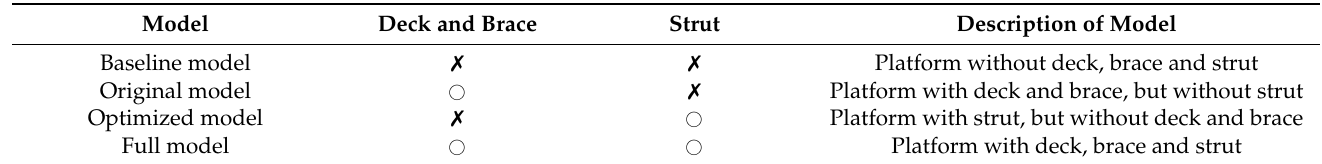
Table 5. Description of four models used for the structural optimization of the platform.